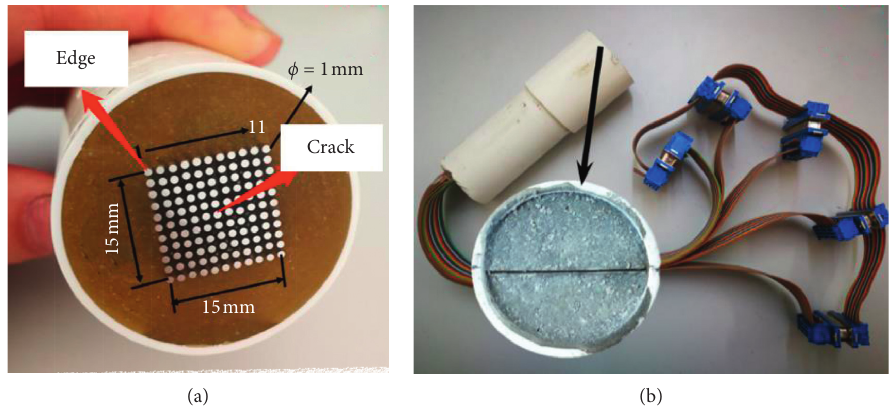
Figure 1: Wire beam electrode specimens: (a) WBE specimen. (b) WBE protected by mortar with cracks.